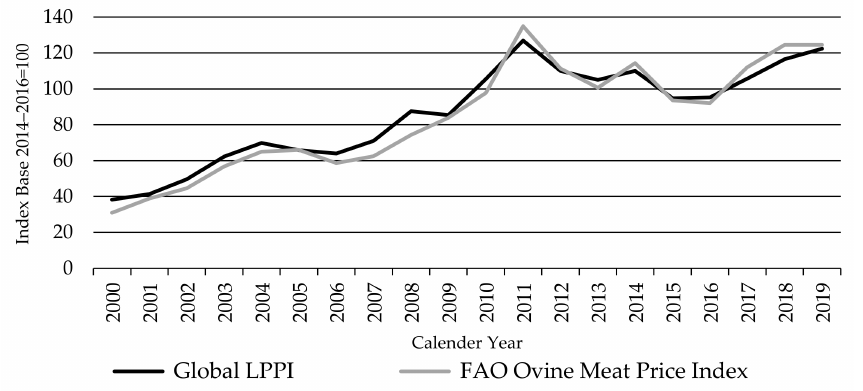
Figure 16. The Global Lambs Producer Price Index LPPI and the FAO Ovine Meat Price Index, source: own illustration, FAO index [63].